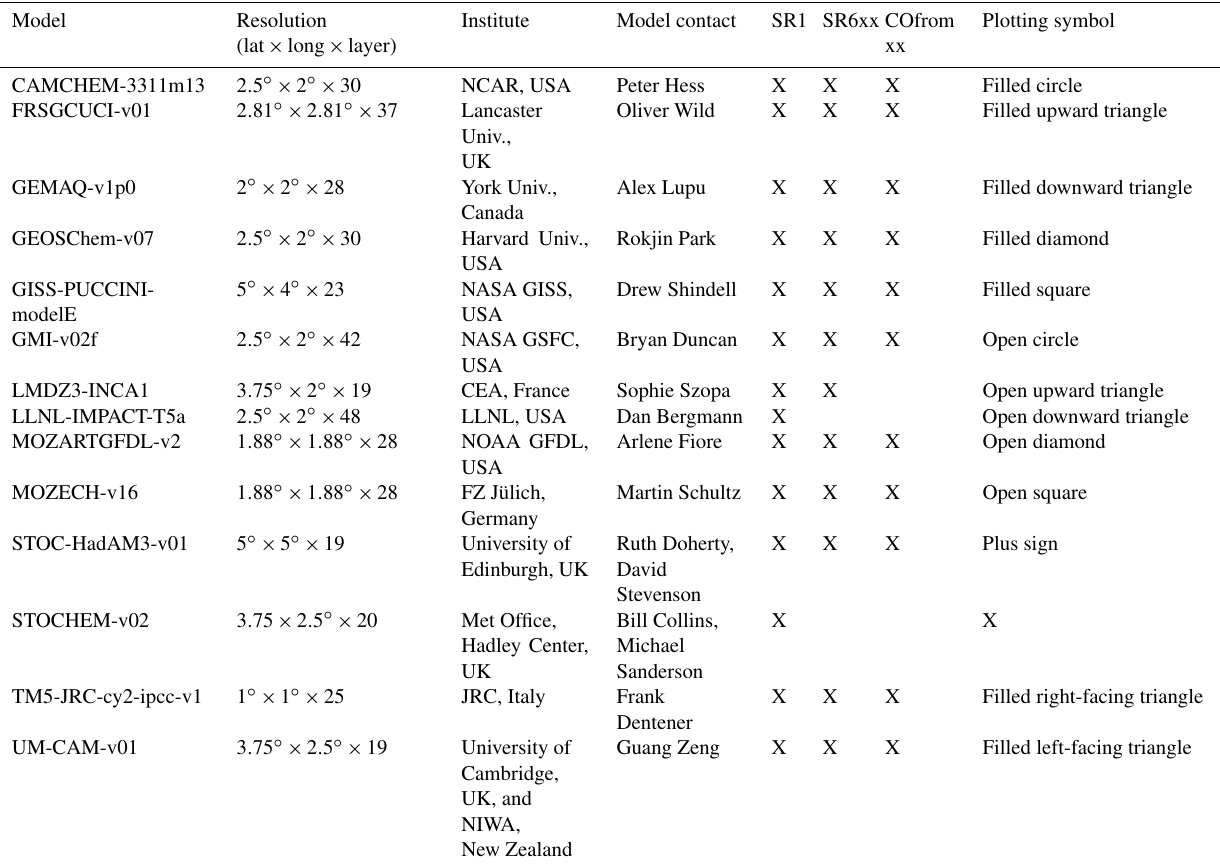
Table 1. Models contributing to the HTAP1 simulations (SR1, SR6xx, and COfromXX) used in this study.